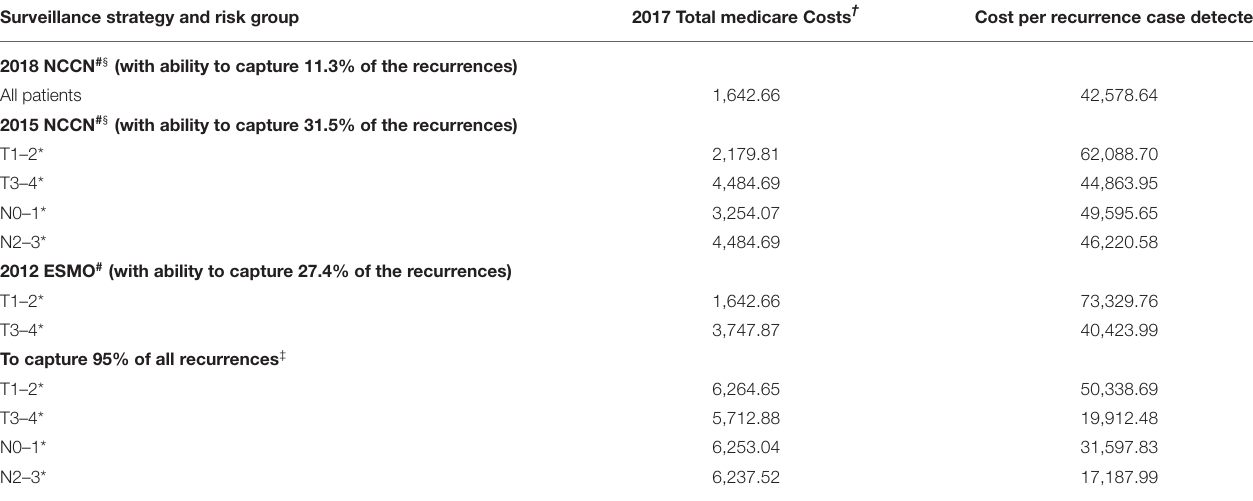
TABLE 5 | Comparison of 2017 medicare costs associated with adhering to the NCCN and ESMO oncologic surveillance schedules and the costs that would be incurred if 95% of all recurrences were captured. Surveillance strategy and risk